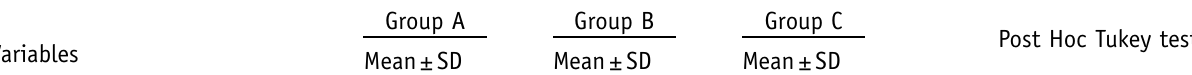
Table II. Descriptive analysis showing mean, standard deviation (SD) and post hoc Tukey test of histological variables of Group A, B and C at day